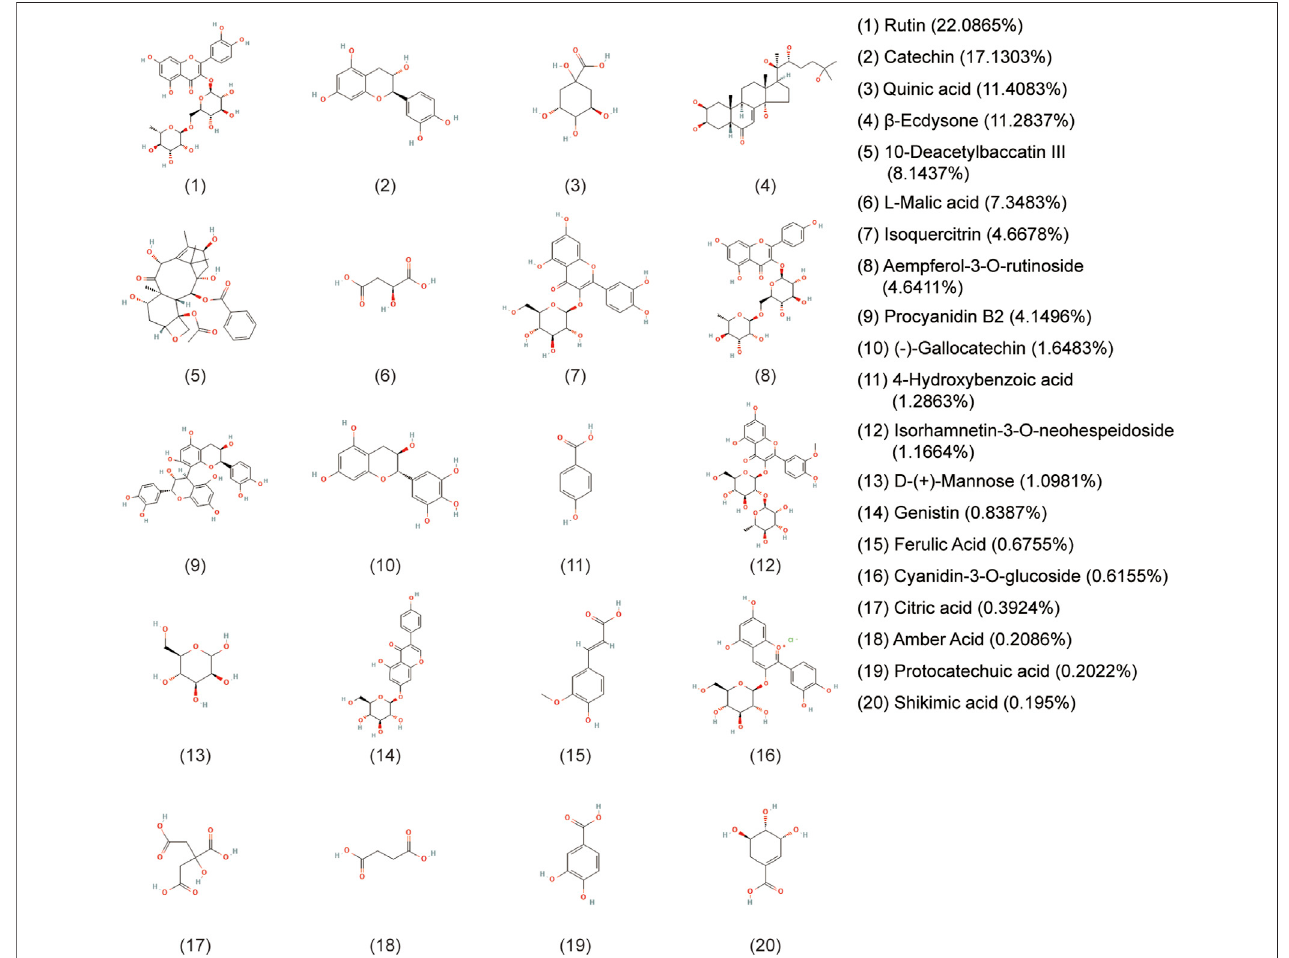
FIGURE 3 | Molecular structural formulas of the major chemical components in AETW and their